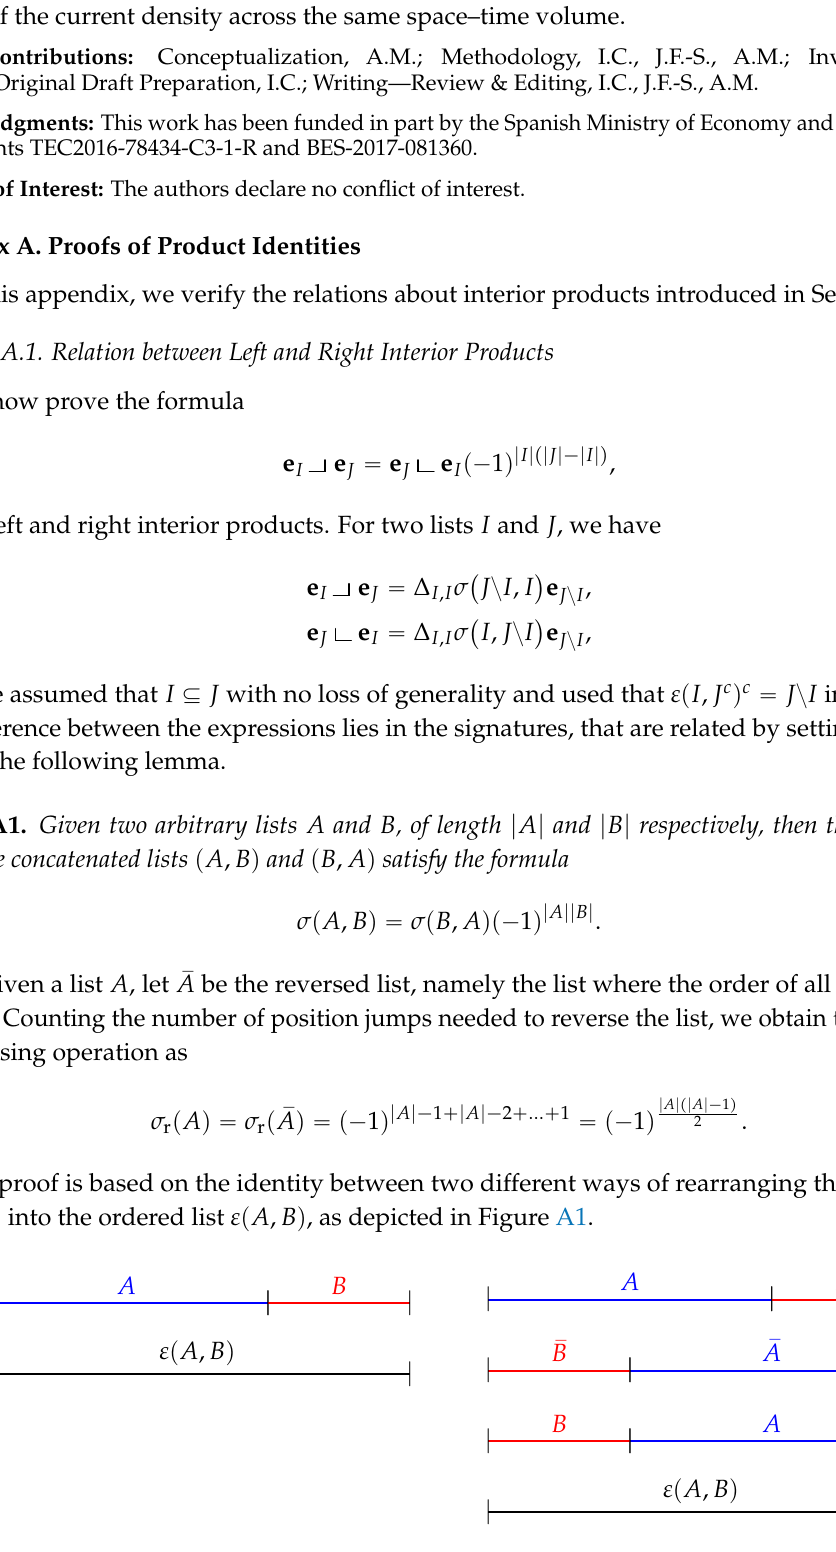
Figure A1. Visual aid for the relation between σ p A , B q and σ p B , A q